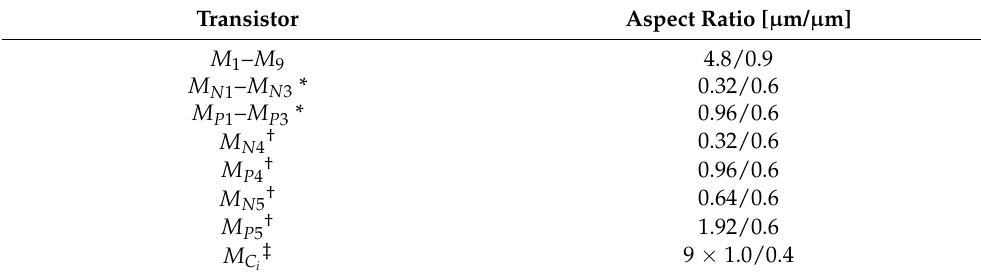
Table 1. Transistor aspect ratios of